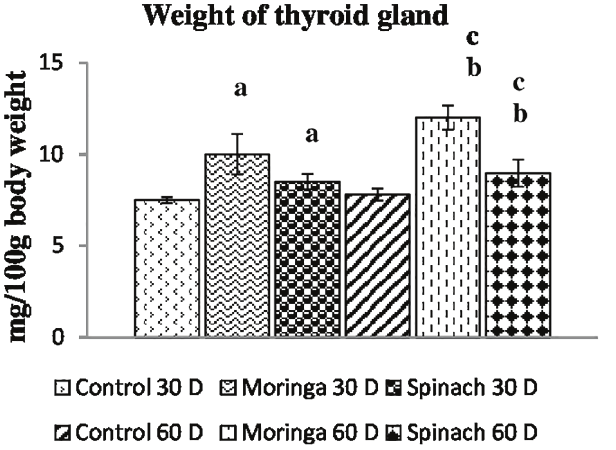
FIGURE 1 - Changes in the relative thyroid gland weight of rats subjected to moringa leaves and spinach respectevely for 30 days and 60 days. Each bar denotes mesn±SD; n=8. One-way analysis of cariance (ANOVA) test followed by Tukeys’s post hoc test was done to determine differences across means of different groups. Mean values are significantly different by ANOVA at p<0.05. a Control 30 days versus treated 30 days group; b Control 60 days versus treated 60 days ggroup; c Treated 30 days versus treated 60 days